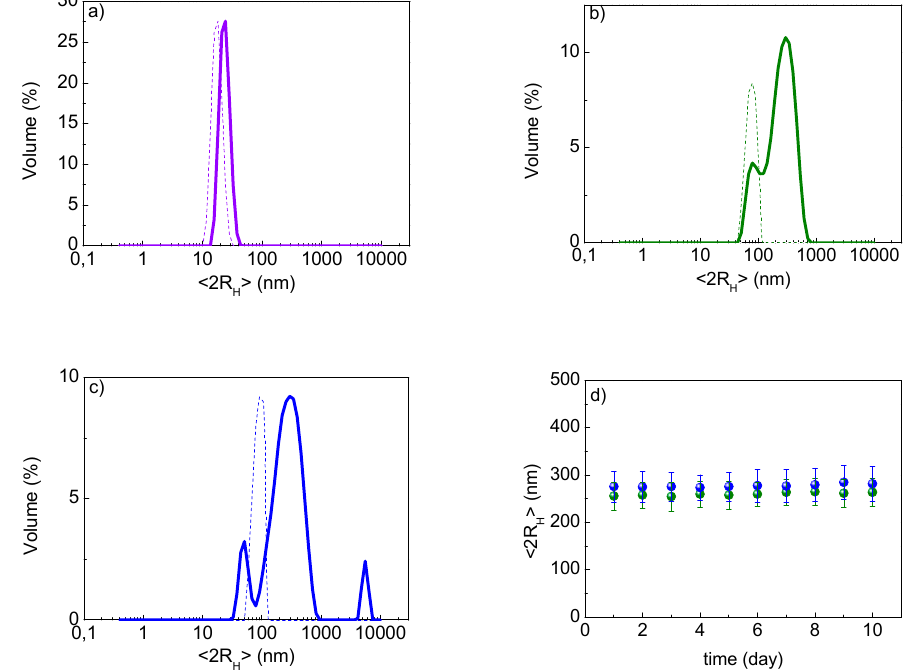
Figure 5. DLS stability study in water of AuNPs in violet, AuNPs-A in green and AuNPs-B in blue: ( a ) AuNPs < 2R H > before (dashed line) 15 ± 2 nm and after samples lyophilization (solid line) 25 ± 5 nm; ( b ) AuNPs-A < 2R H > before (dashed line) 56 ± 30 nm and after lyophilization (solid line) 256 ± 30 nm; ( c ) AuNPs-B < 2R H > before (dashed line) 76 ± 32 nm and after lyophilization (solid line) 276 ± 32 nm; ( d ) < 2R H > of lyophilized AuNPs-A and AuNPs-B re-suspended in water at different days, up to 10